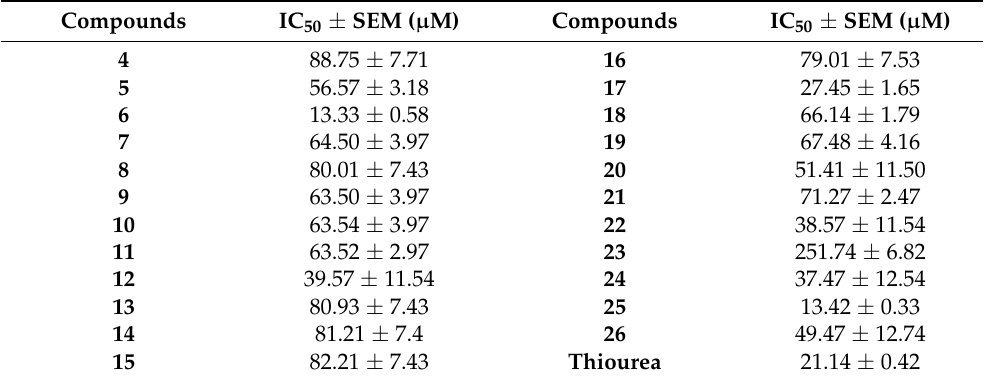
Table 7. In vitro urease inhibitory activity of synthesized N (cid:48) -benzylidene-4-(t-Bu)benzohydrazide derivatives ( 4 – 26